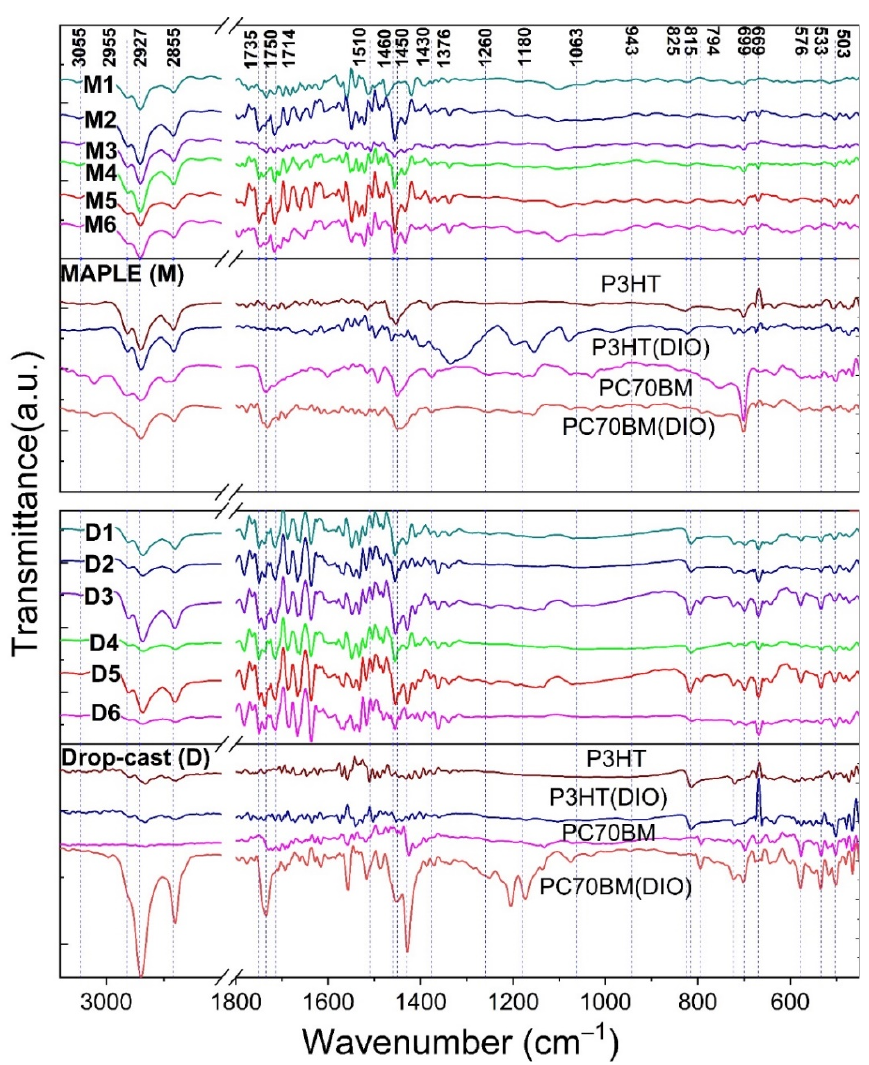
Figure 2. FTIR spectra of the drop-cast (D) and MAPLE (M) films onto silicon substrates. The index indicates the solutions (according to Table 1) used as target in their deposition.